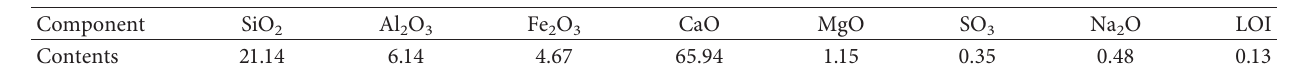
Table 2: Chemical compositions of cement.